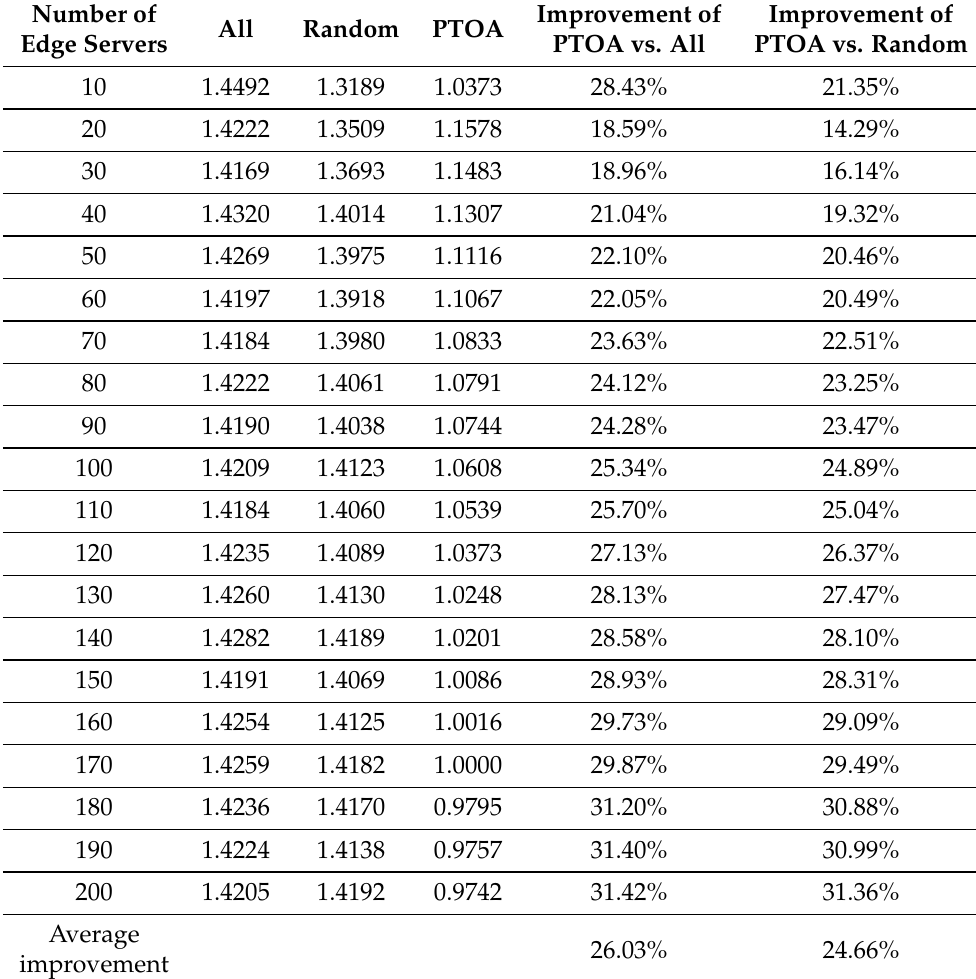
Table 6. Comparison of the location privacy-preserving ability of PTOA with the methods All and Random with different numbers of edge